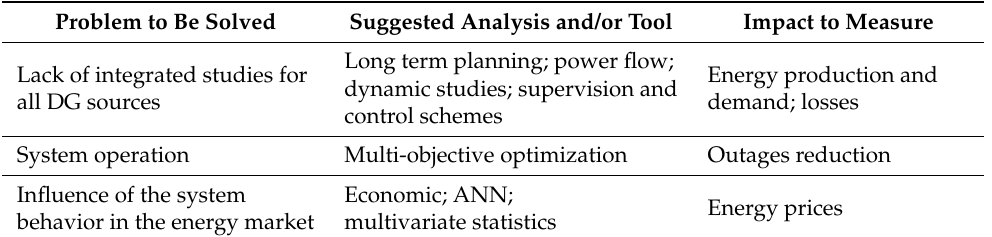
Table 7. Problems, suggestions, and impacts of DG. Source: own study. Problem to Be